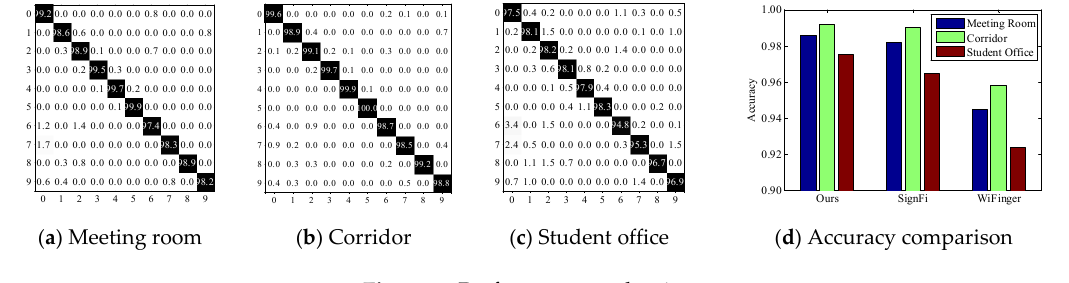
Figure 9. Performance evaluation. Table 1. A comparison of state-of-the-art works for Wi-Fi-based gesture recognition. Properties